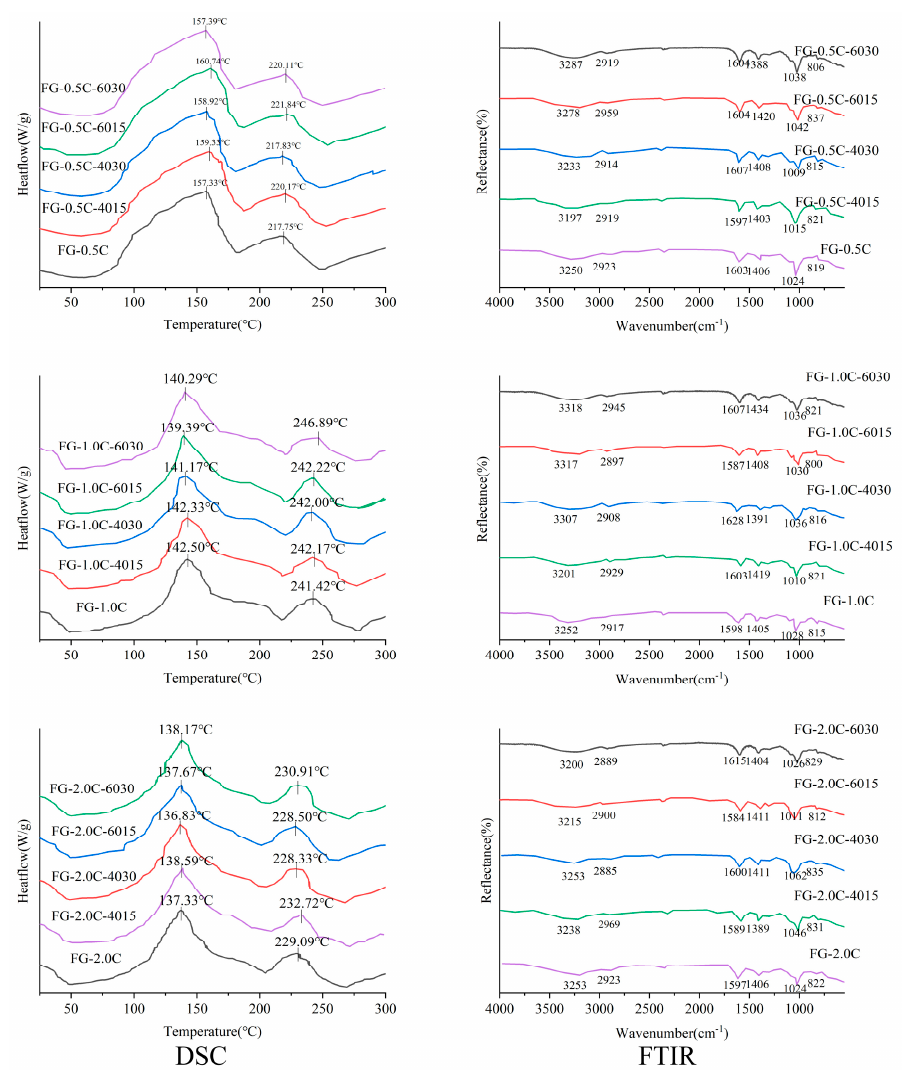
Figure 3. Effect of sonication on differential scanning calorimetry (DSC) (left) and Fourier transform infrared spectroscopy (FTIR) (right) results of flaxseed gum films incorporated with carvacrol.